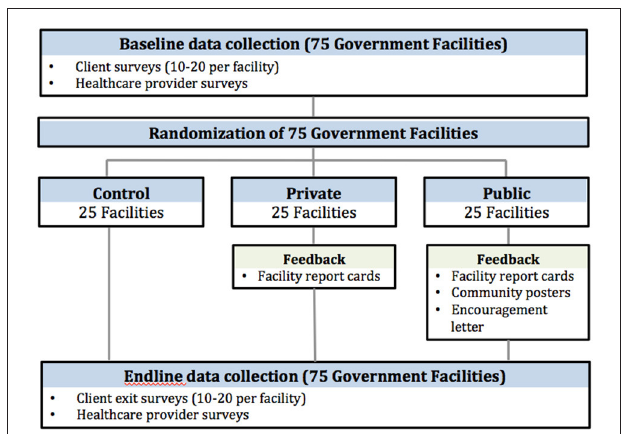
FIGURE 2 | Outline of the BASI study